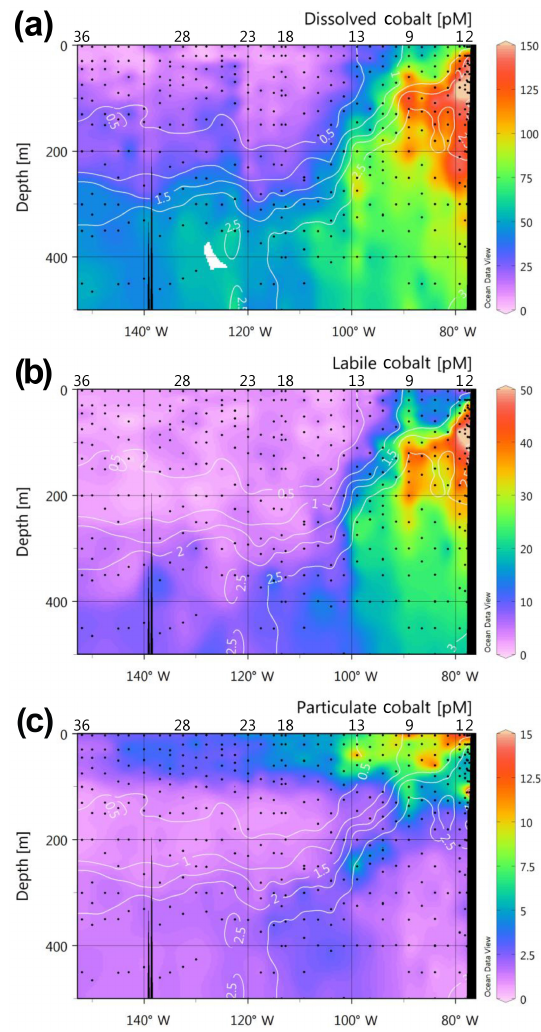
Figure 6. Dissolved cobalt (a) , labile dissolved cobalt (b) , and par- ticulate cobalt (c) gradients in the upper 500m of the ETSP. White lines in both panels show dissolved PO 4 contours at 0.5µM incre- ments. Interpolation was conducted using weight-averaged gridding with 40 and 46‰ length scales in the x and y directions, respec-